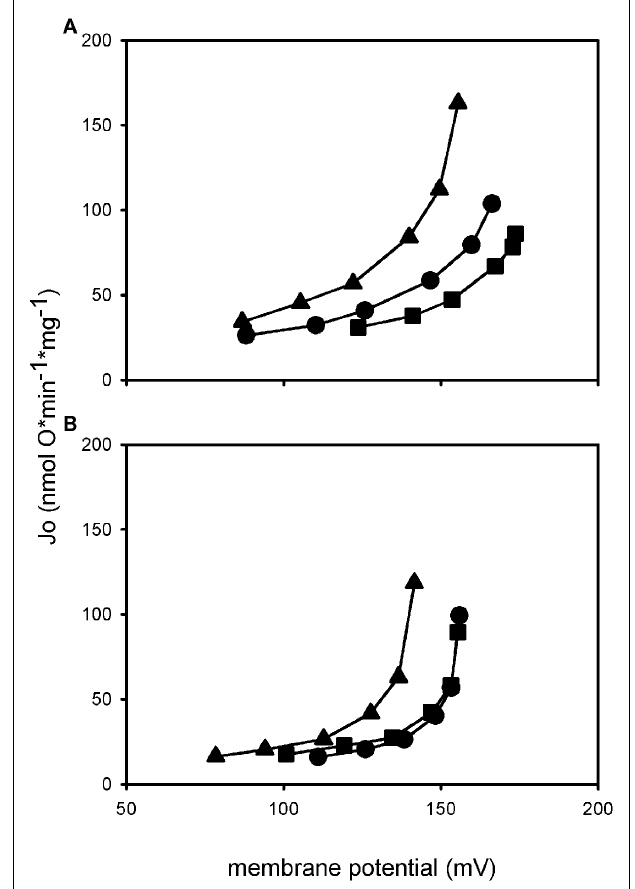
FIGURE 3 | Proton leak kinetics of isolated mitochondria. Mitochondria from HEK UCP1 cells (A) and mitochondria from a differentiated brown preadipocyte cell line (B) . Addition of palmitate (triangle) in both systems leads to an increase in proton leak compared to basal conditions (circle), indicated by the upwards shift of the curve. Coincubation with GDP (square) prevents the activation by palmitate, demonstrating that it is mediated by UCP1. Proton conductance of HEK UCP1 mitochondria in the presence of GDP is lower than under basal conditions, whereas mitochondria from brown adipocytes are coupled back to basal